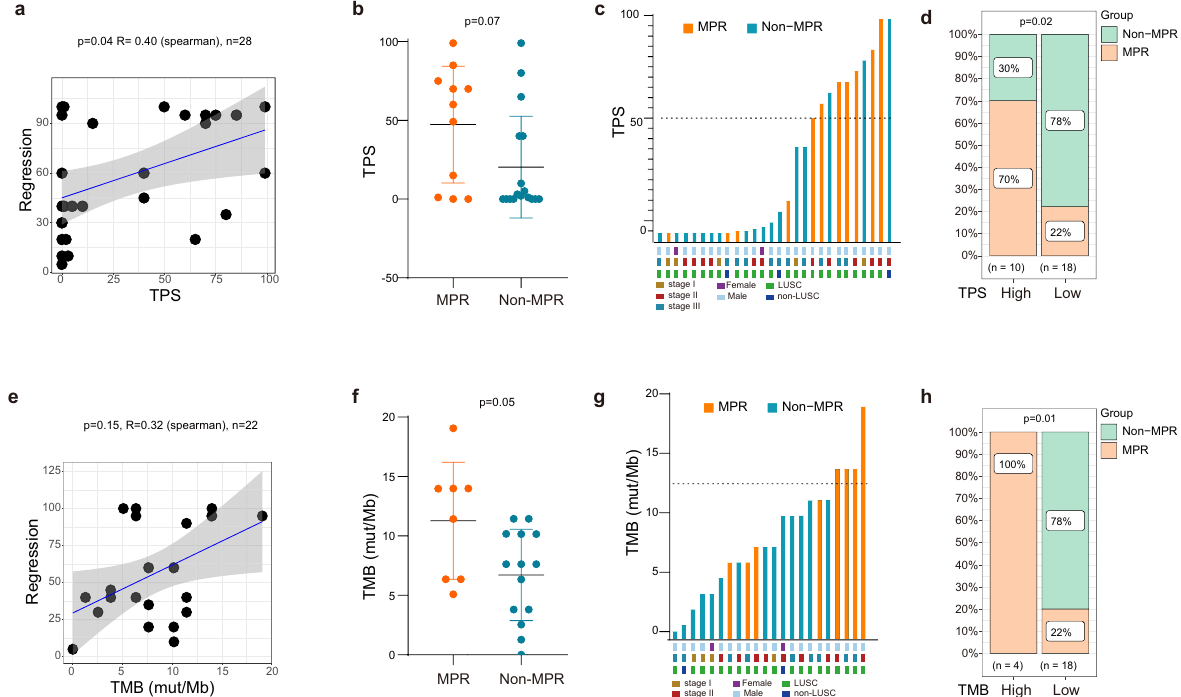
Fig. 1 The association of PD-L1 expression and TMB with pathologic response to sintilimab. a The correlation between pathological regression and TPS (Spearman ’ s correlation coef fi cient R = 0.40, p = 0.04). b Comparison of TPS in MPR and Non-MPR group (p = 0.07, Mann – Whitney U test). c , d Distribution of MPR and Non-MPR patients in groups with high ( ≥ 50%) or low TPS ( < 50%) (p = 0.02, Fisher ’ s exact test). e The correlation between pathological regression and TMB (Spearman ’ s correlation coef fi cient R = 0.32, p = 0.15). f Comparison of TMB in MPR and Non-MPR group (p = 0.05, Mann – Whitney U Test). g , h Distribution of MPR and Non-MPR patients in groups with high (>12 muts/ mb) or low TMB ( < 12 muts/mb) ( p = 0.01, Fisher ’ s exact